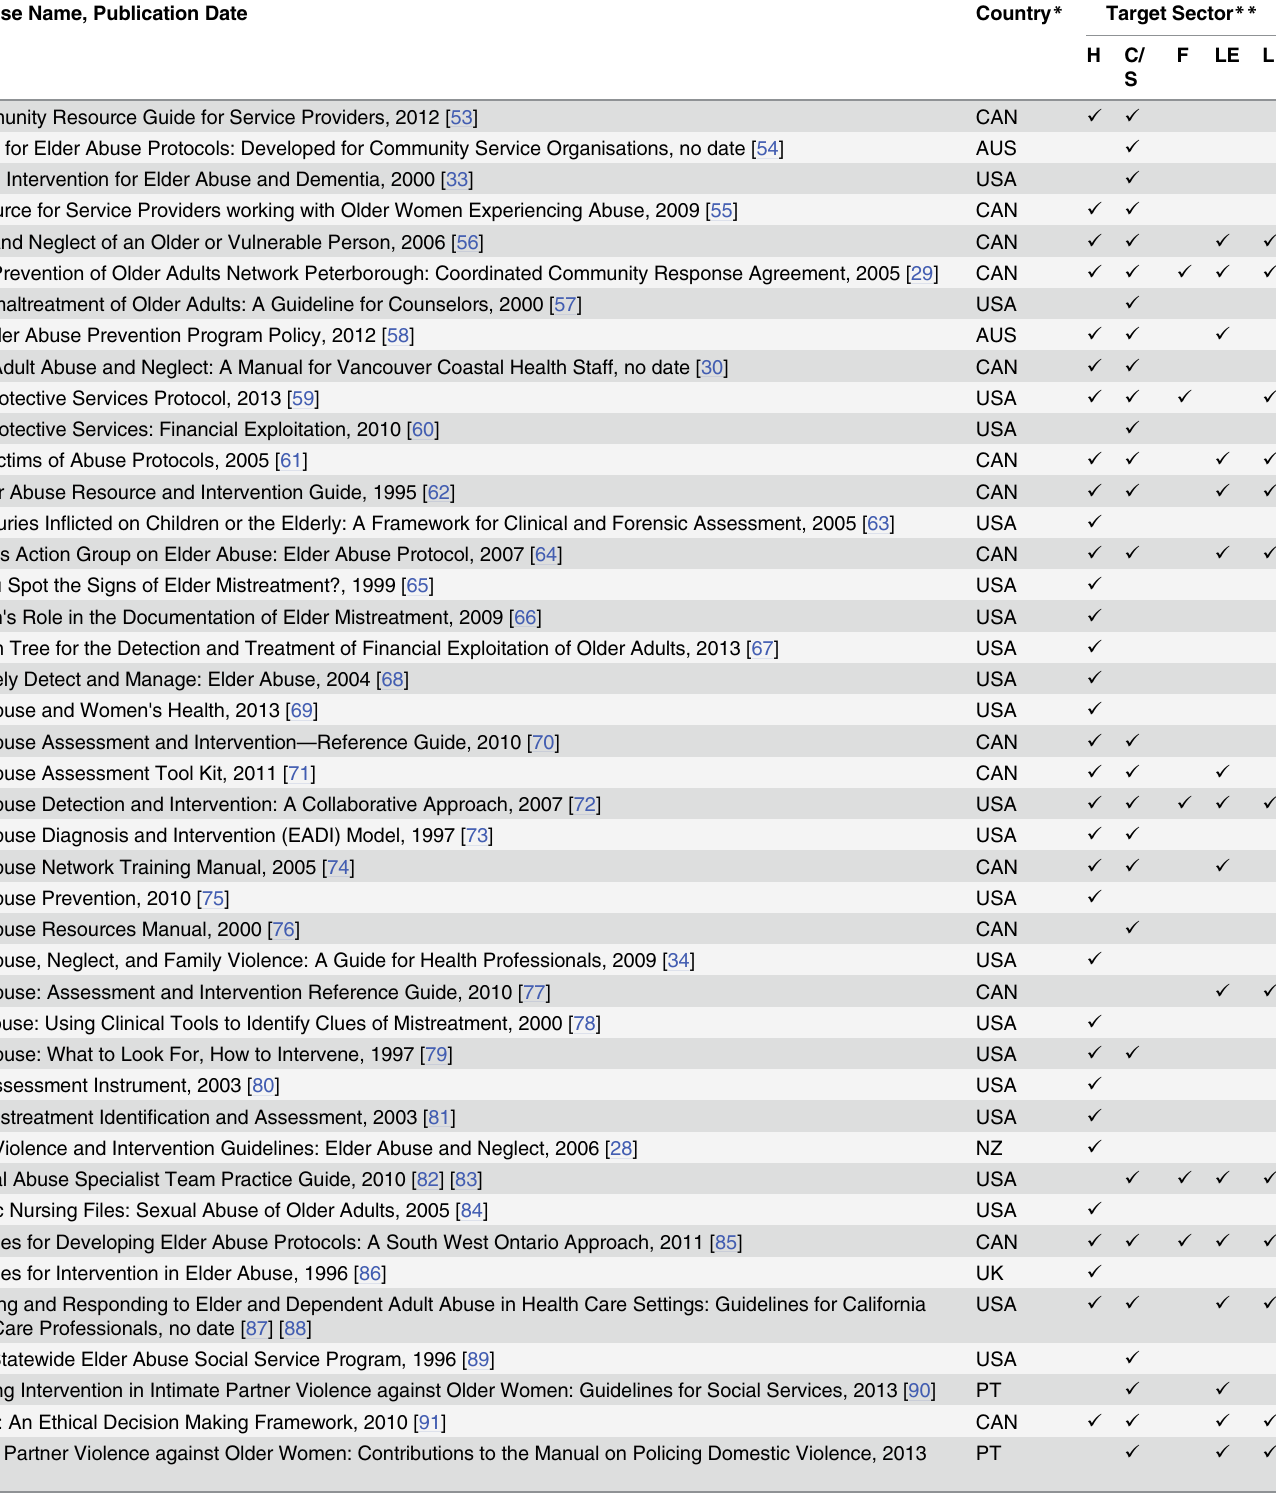
Table 1. Characteristics of the Responses to Elder